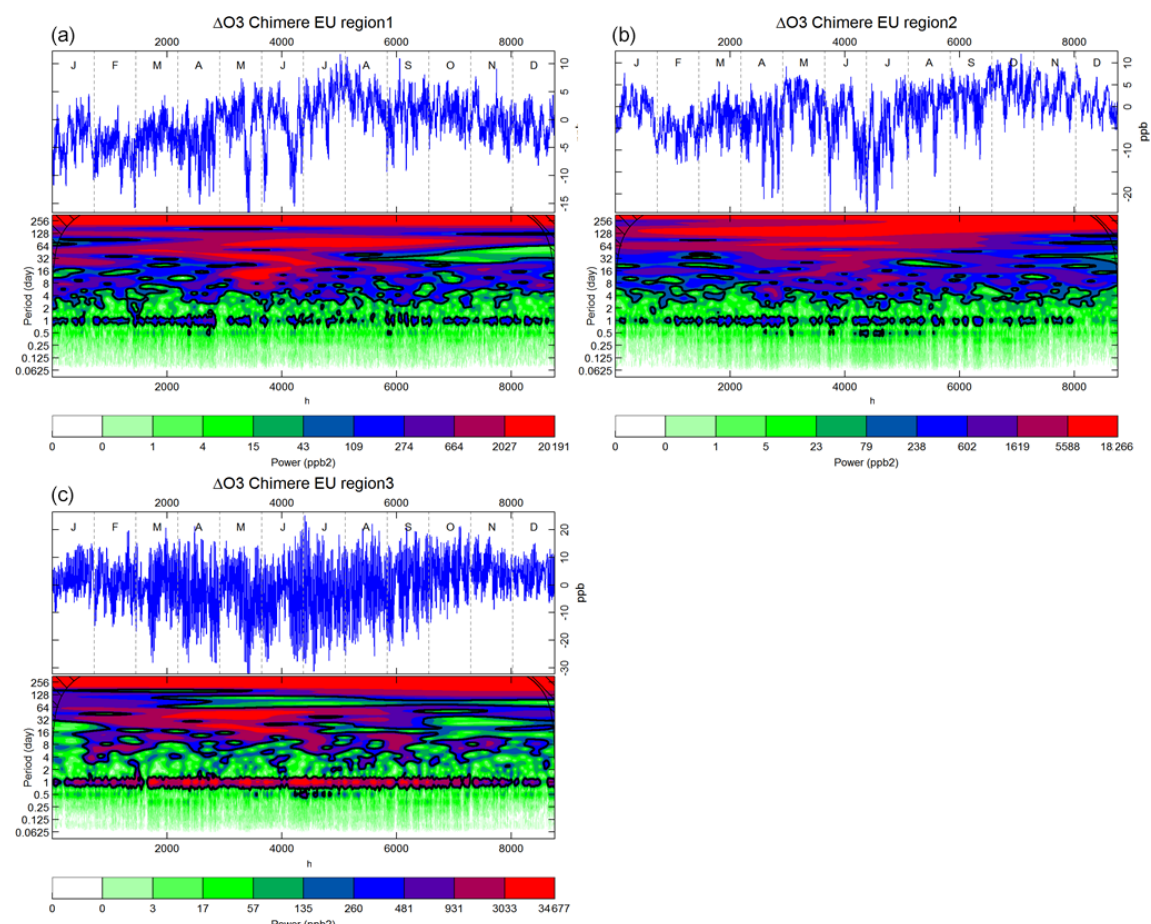
Figure 19. Same as in Fig. 18 for Chimere over the three EU subregions.